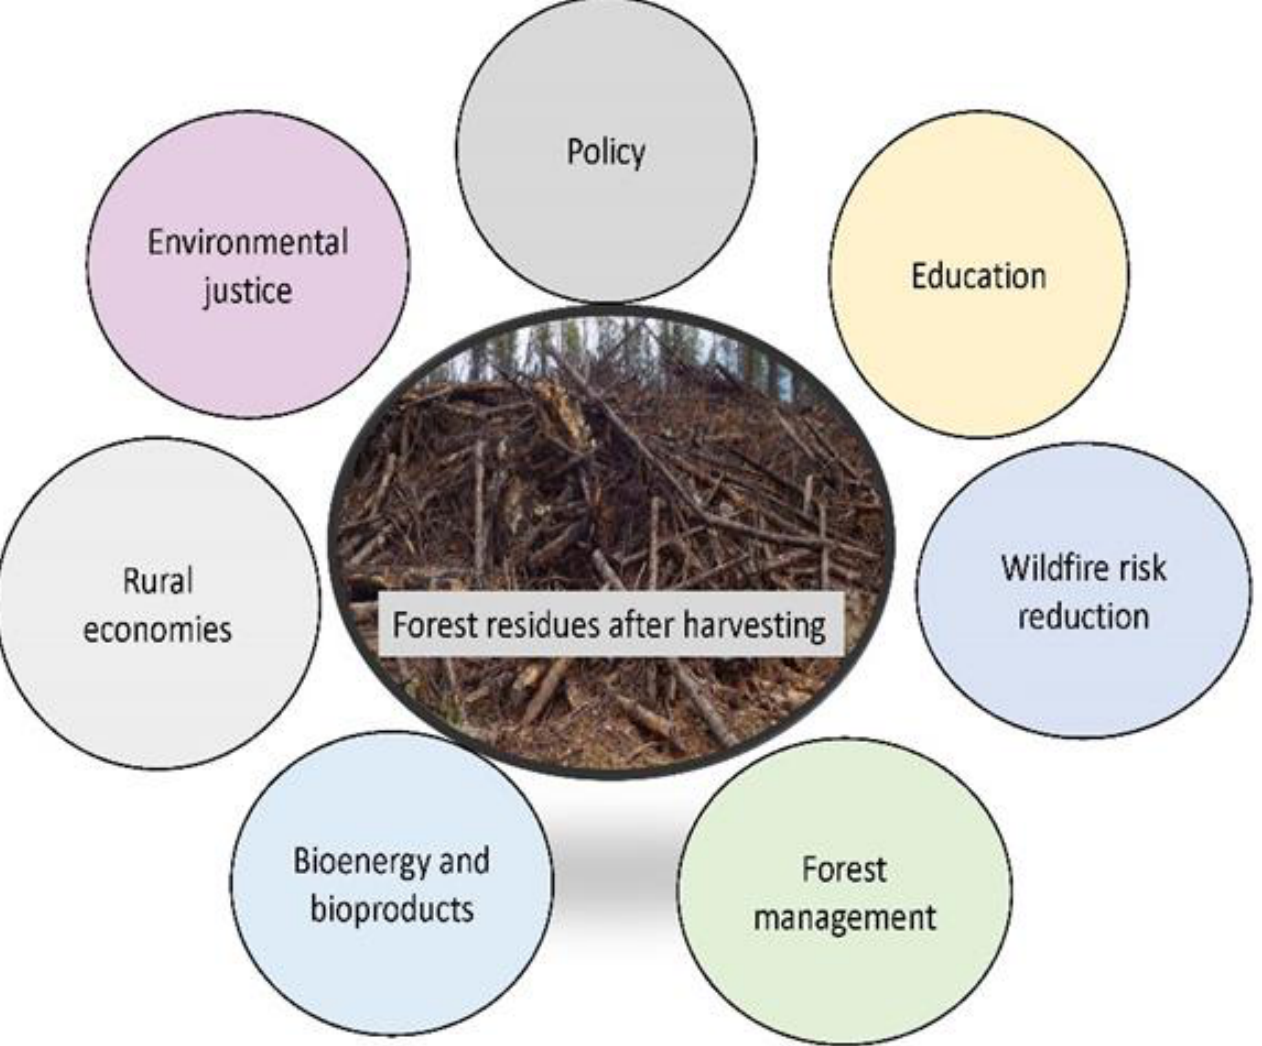
Figure 1. The post-harvest fate of woody residues for bioenergy and bioproducts is dependent on, and integral to, many diverse factors.